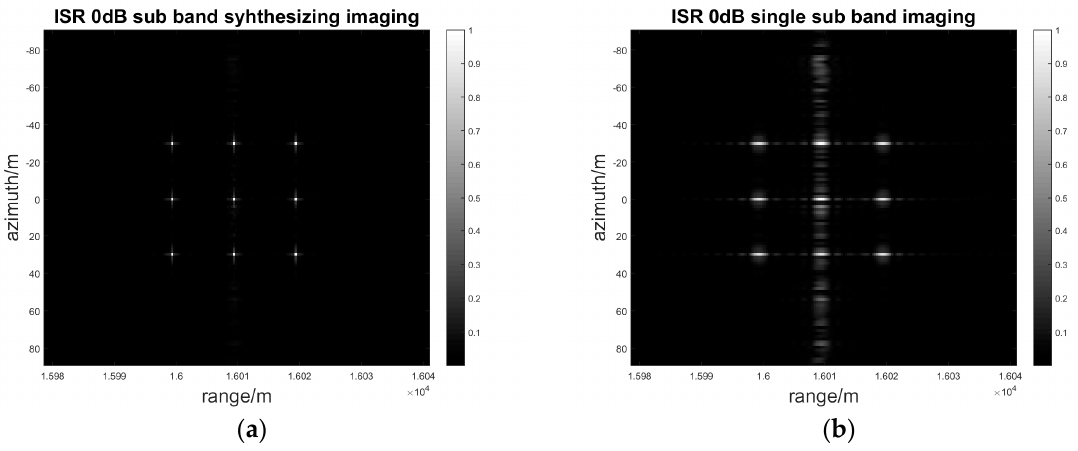
Figure 12. ISR 0 dB sub-band synthesizing and single sub-band imaging result: ( a ) Sub-band synthesis of a two-dimensional gray image; ( b ) Single sub-band of a two-dimensional gray image.